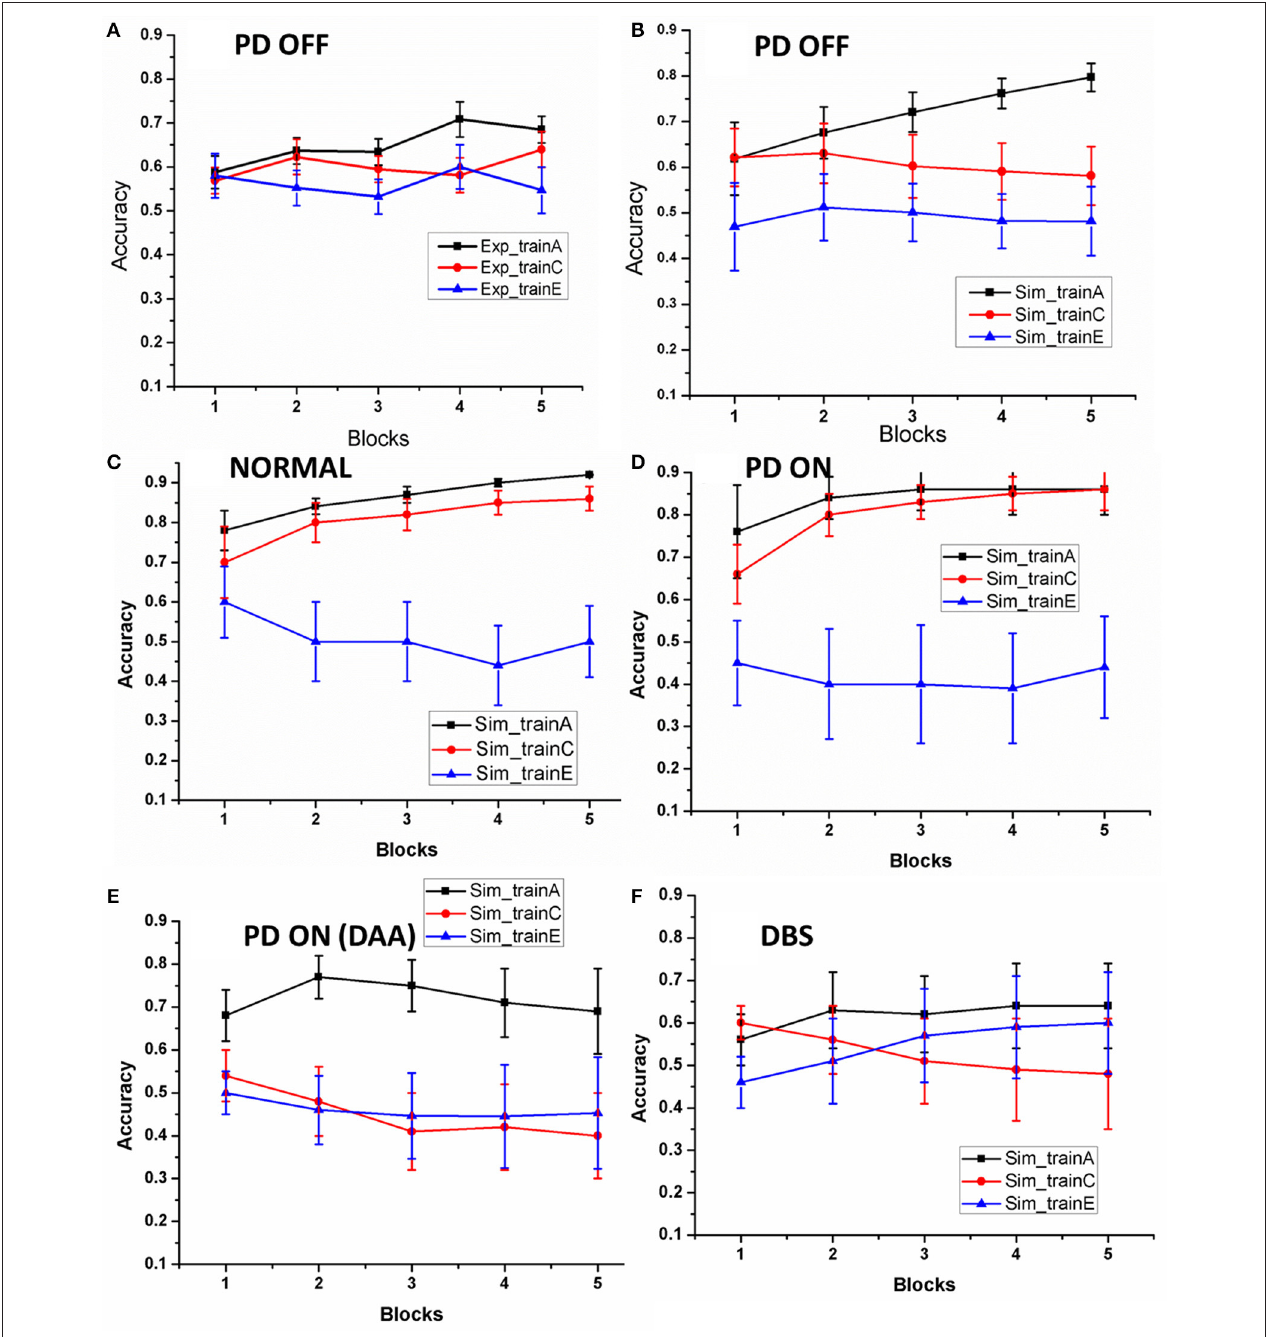
FIGURE 3 | The accuracy of the model as the training progressed: (A) results redrawn from Zaghloul et al. (2012), (B) performance of the spiking model in PD OFF condition, (C) Normal, (D) PD ON, (E) PD ON (DAA), and (F)DBS. The x-axis is the progression in training trials which were divided in to five equal blocks. The y-axis indicates the mean accuracy with standard error